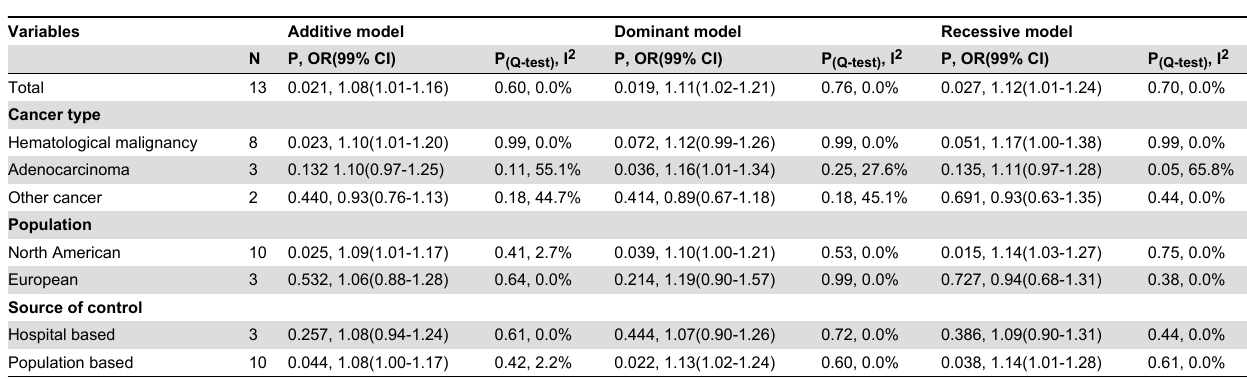
Table 4. Meta-analysis of